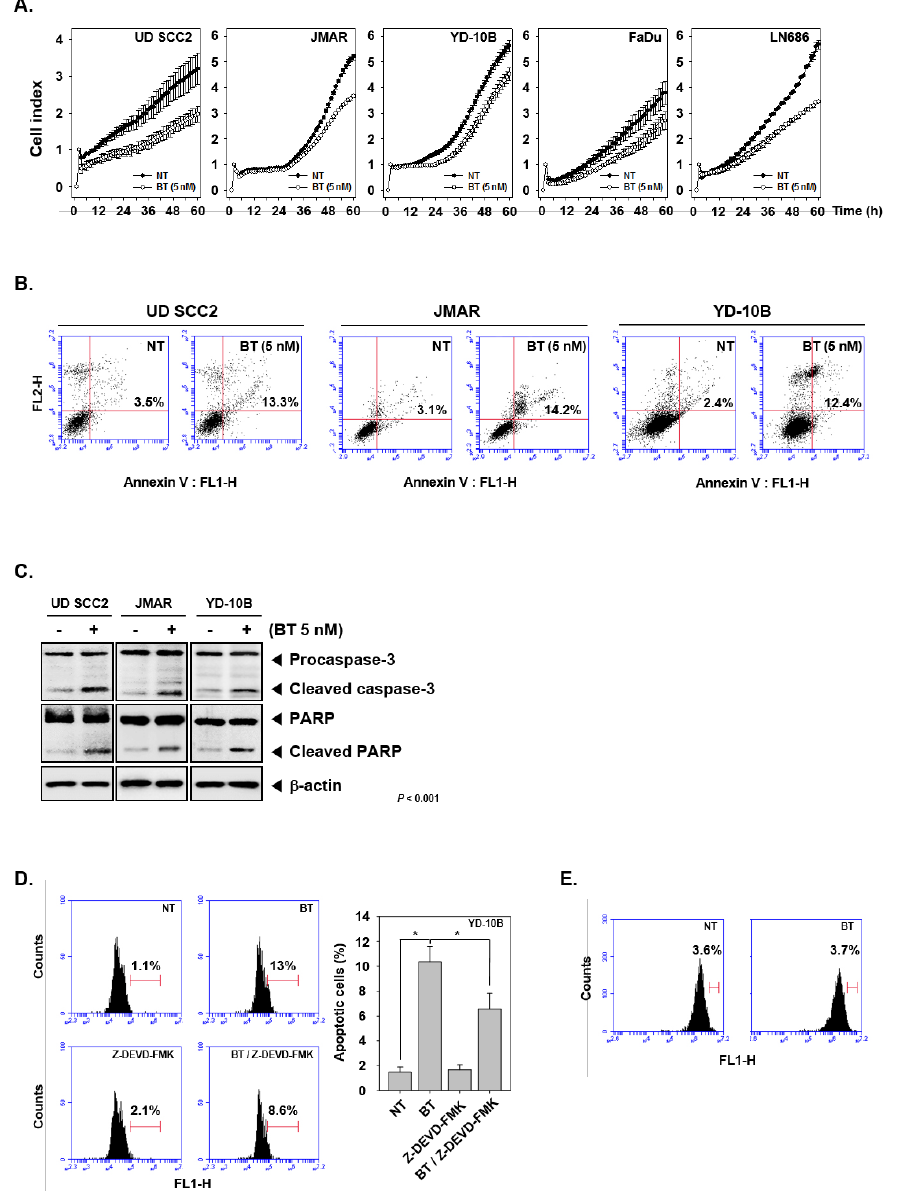
Figure 4. BT inhibits cell proliferation and induces apoptosis in HNSCC. ( A ) HNSCC (UD SCC2, JMAR, YD-10B, FaDu, and LN686) cells were either non-treated (NT) as control or treated with 5 nM of BT. Then continuously monitored using the Roche xCELLigence Real-Time Cell Analyzer (RTCA) DP instrument (Roche Diagnostics GmbH, Germany). ( B ) HNSCC (UD SCC2, JMAR, YD-10B) cells were treated with 5 nM of BT for 48 h. The cells were incubated with a FITC conjugated Annexin V, then examined for an early apoptotic e ff ect with flow cytometry. ( C ) HNSCC cells (UD SCC2, JMAR, and YD-10B) were treated with 5 nM of BT for 48 h and western blotting was performed using antibodies against Caspase-3 and PARP. β -actin was used as an input control to verify equal protein loading. ( D ) YD-10B Cells were pre-treated with or without a Z-DEVD-FMK (caspase-3 inhibitor; 20 µ M) 1 h before being treated with 5 nM BT for an additional 48 h. The cells were incubated with an FITC-conjugated Annexin V antibody and then analyzed by flow cytometry. The graph indicated quantitative analysis of apoptotic cells. ( E ) YD-10B cells were treated with 5 nM of BT for 48 h. Cells were incubated with 10 µ M of DCFH-DA for 20 min at 37 ◦ C then DCF fluorescence was measured by flow cytometry. * indicates p value less than